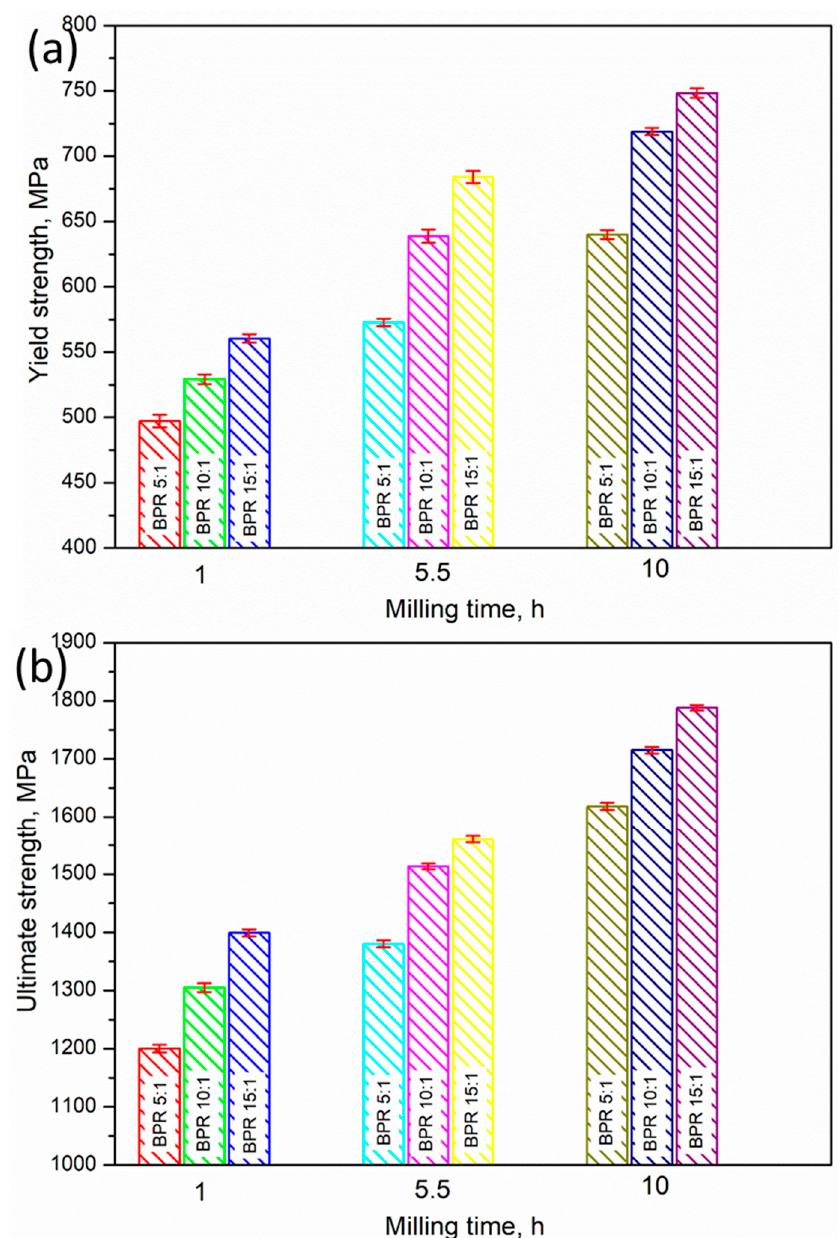
Figure 12. Variation in yield strength and ultimate strength with milling time and BPRs for FeMn 30 Cu 5 biodegradable alloys: ( a ) yield strength; ( b ) ultimate strength.